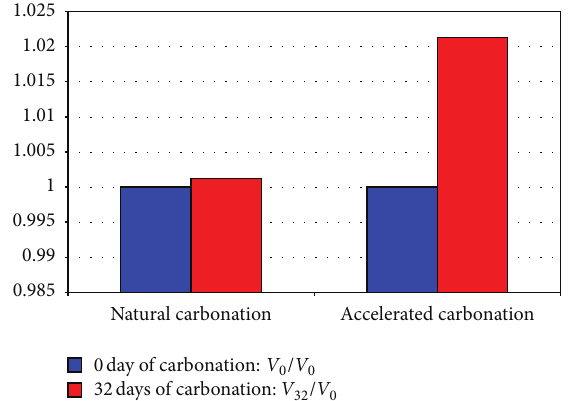
Figure 17: Evolution of the solid phase volume during accelerated carbonation and natural